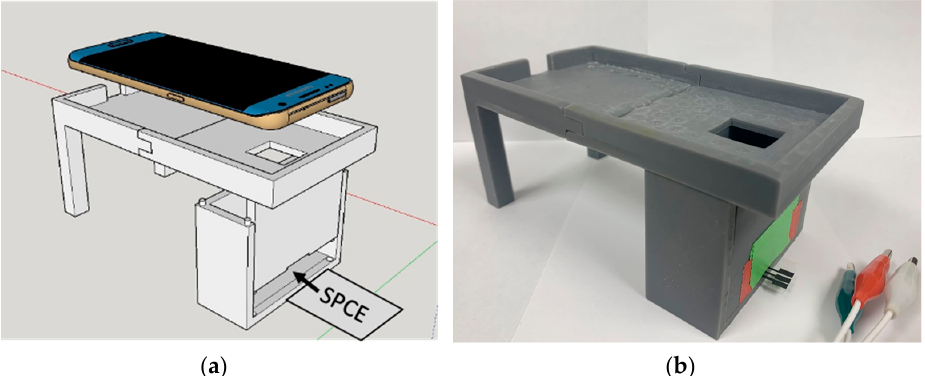
Figure 1. SketchUp 2017 design ( A ) and photograph ( B ) of the light-tight housing and phone holder. The optical detector rests in the tray and uses the small window to image the light-tight chamber. The SPCE is inserted into the closed chamber through a narrow slit as shown. The design is modular and the phone holder can be swapped out with the CCD camera holder (not shown).